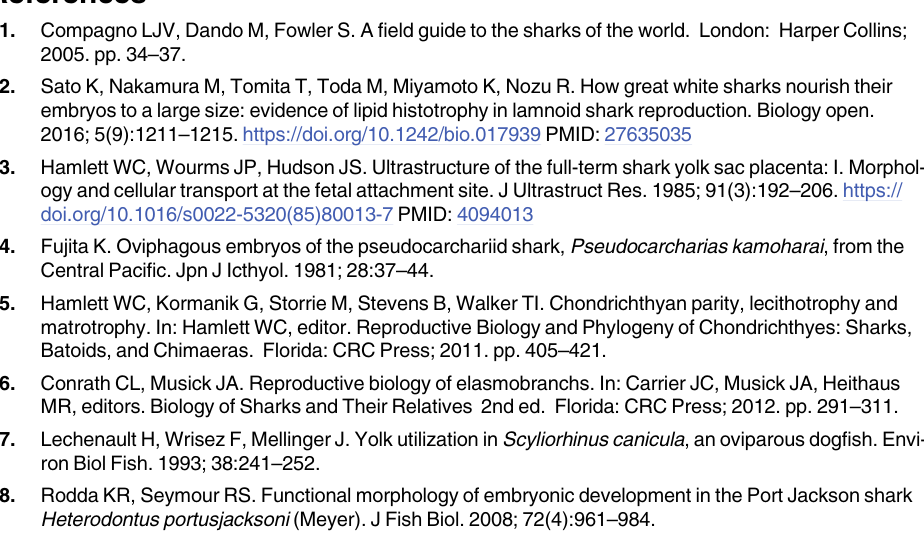
S2 Table. Accession numbers of the genes used in the phylogenetic